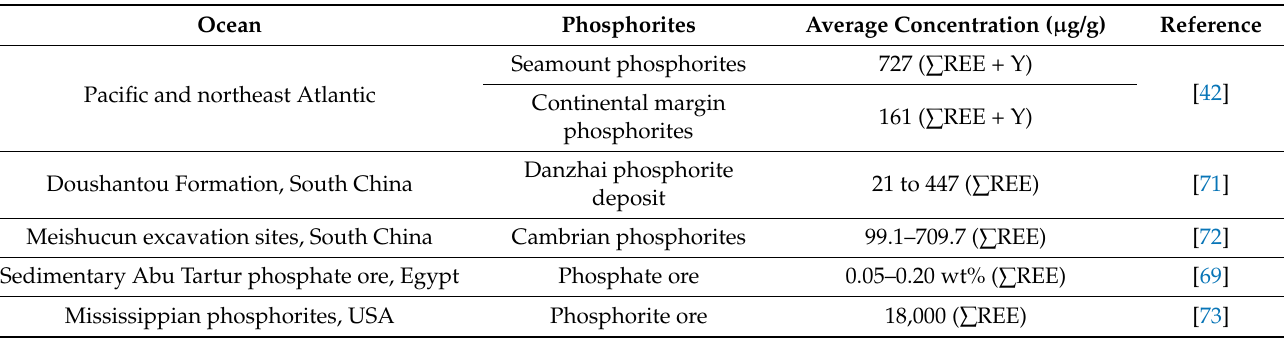
Table 2. Concentrations of REE in marine phosphorites and related rocks from different regions across the